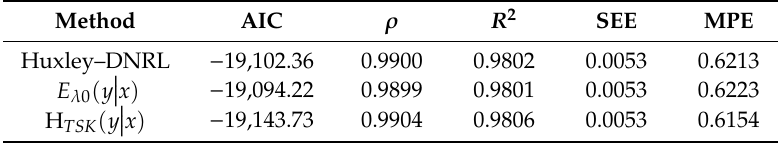
Table A1. Model performance metrics for comparison of proxies by Huxley’s model fitted by